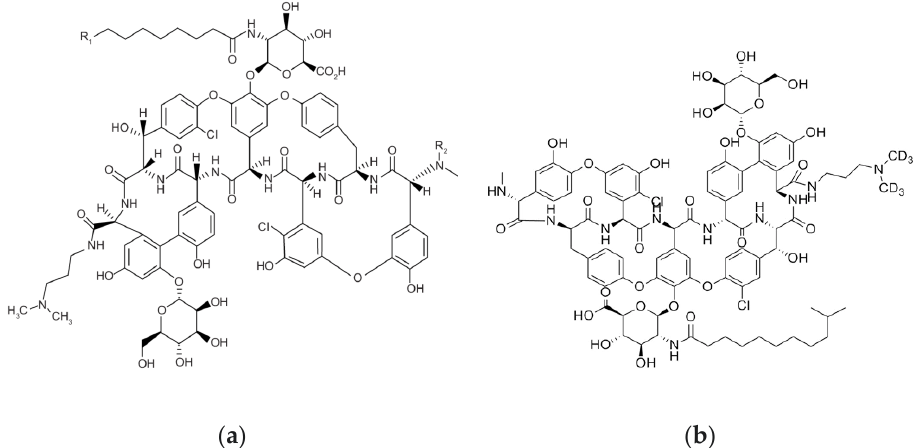
Figure 1. Chemical structure of Dalbavancin ( a ) and of the exa-deuterated analog Dalbavancin-d6 ( b ) used as Internal Standard (IS).